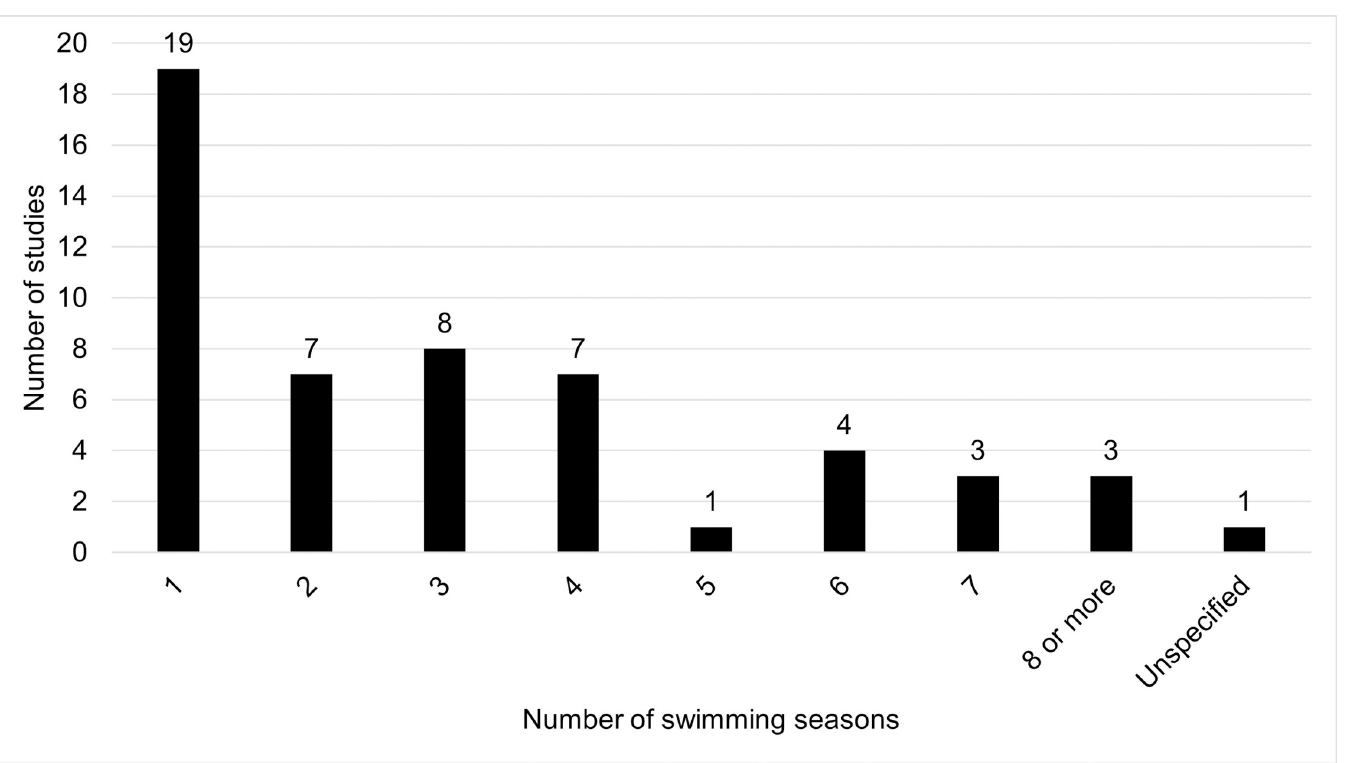
Fig 2. Frequency of the number of swimming seasons used in building